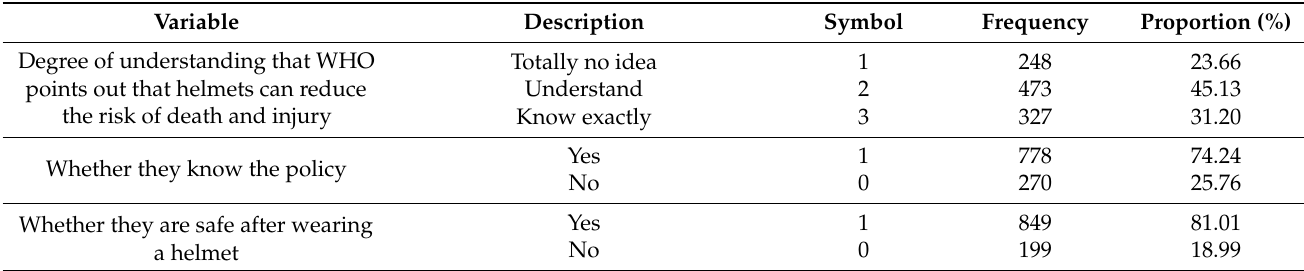
Table 4. Descriptive statistics for subjective attitude